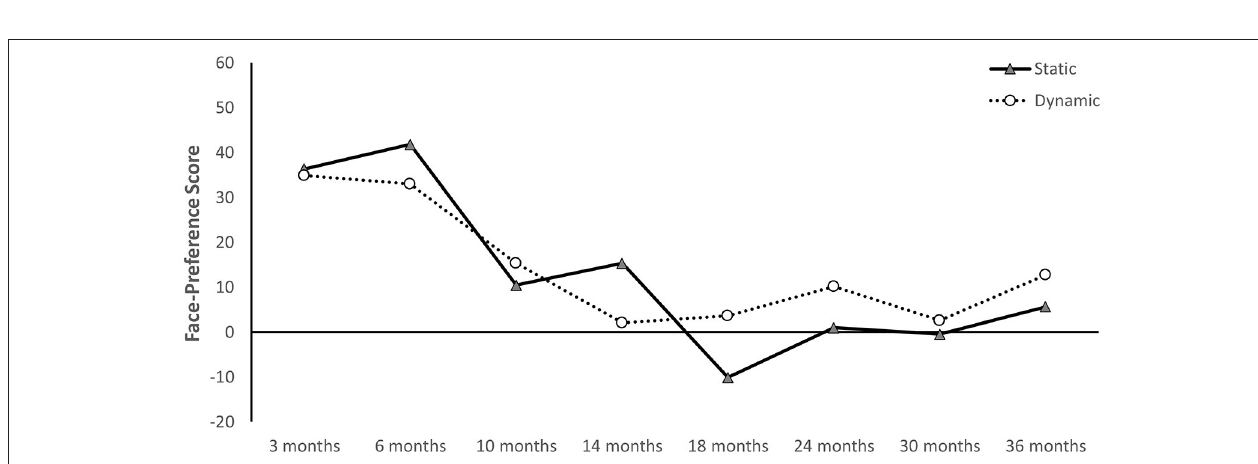
FIGURE 4 | Longitudinal face-preference scores on sub-set of participants who participated across three consecutive age-points. Error bars are SEM. (A) 3–10 months, (B) 6–14 months, (C) 10–18 months, (D) 14–24 months, (E) 18–30 months, and (F) 24–36 months.